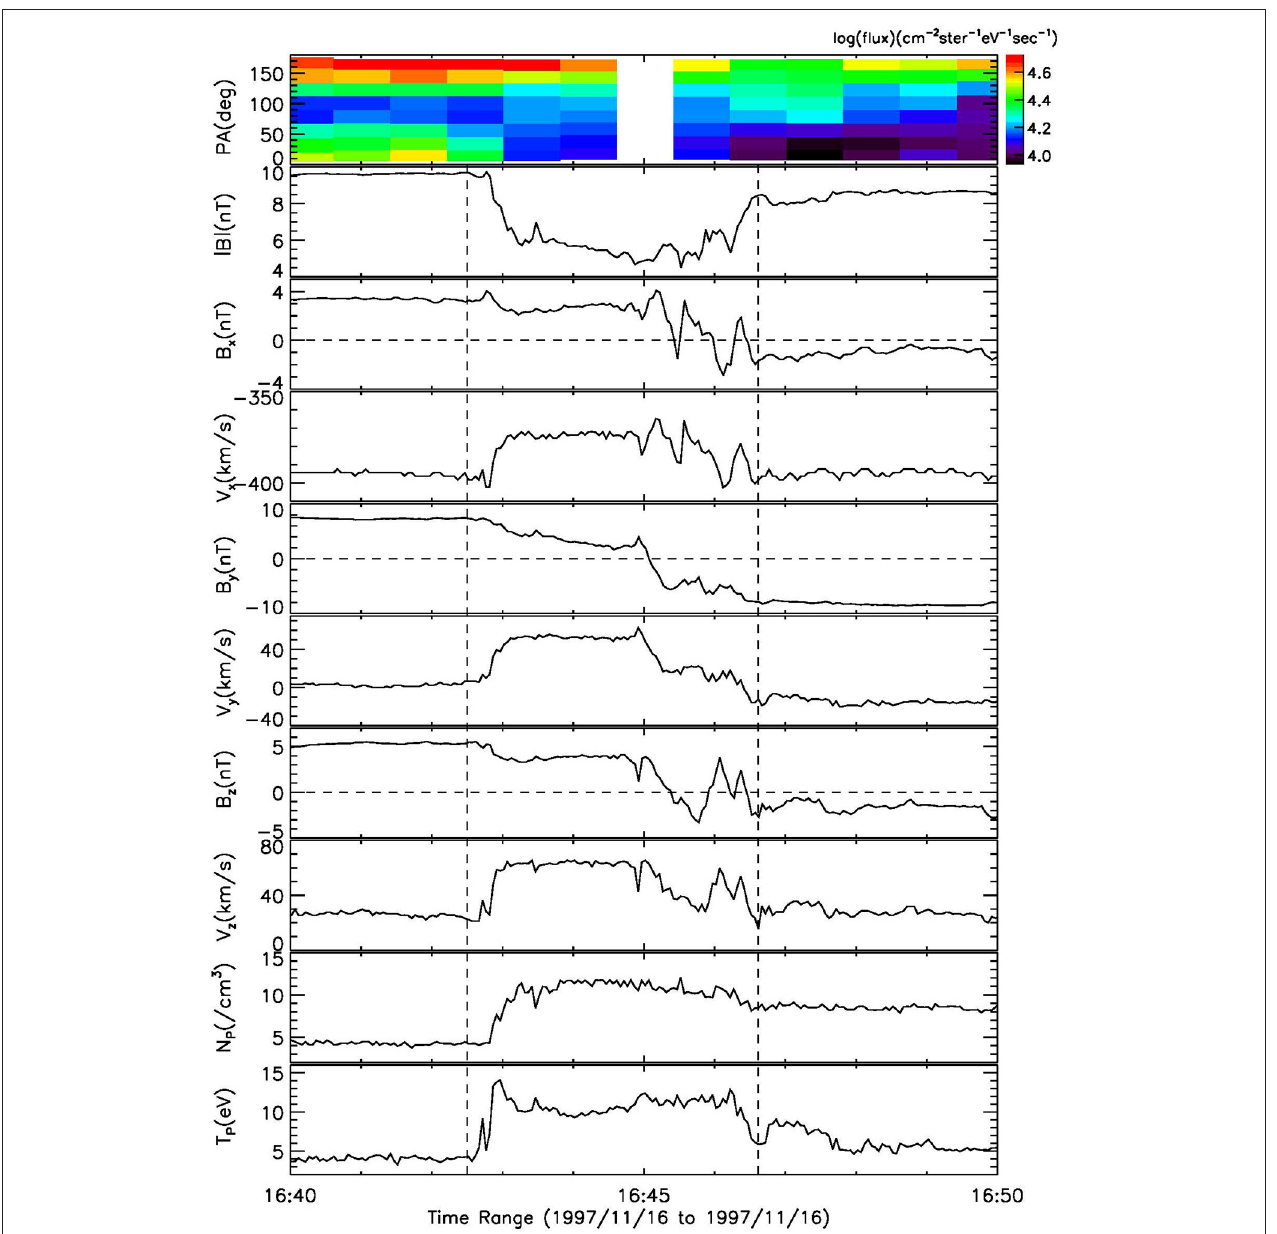
FIGURE 4 | The reconnection exhaust around 16:45 UT November 16th measured by Wind. The format of the figure is same as Figure 2 .